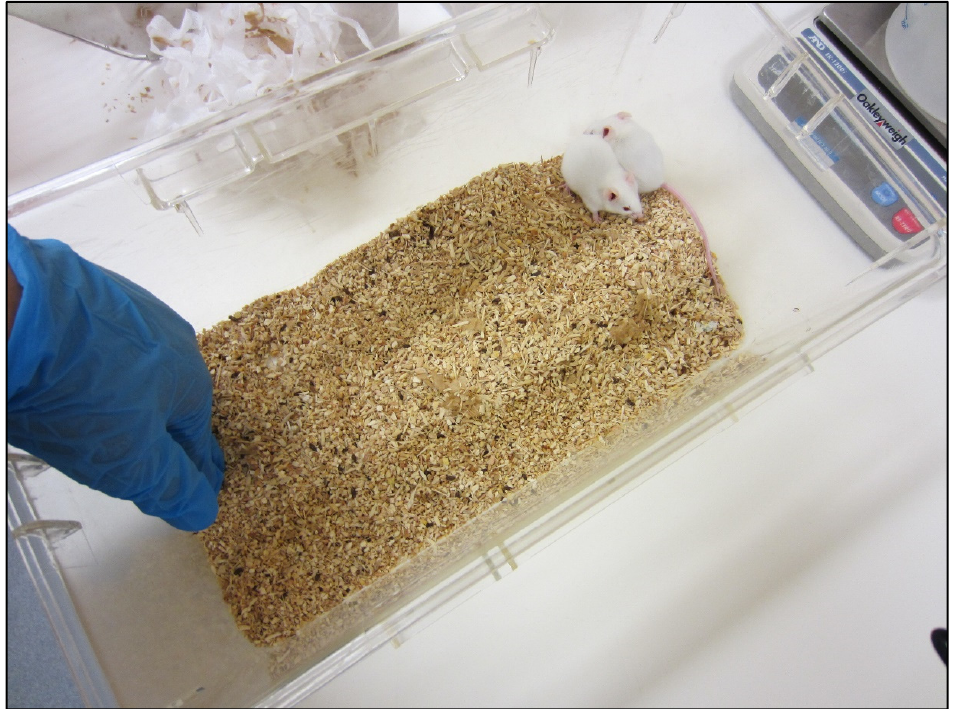
Figure 1. Handler interaction test set-up. The handler’s hand remained motionless for 3 min whilst the voluntary responses of the mice were recorded. The handler wore nitrile gloves, as during mark-